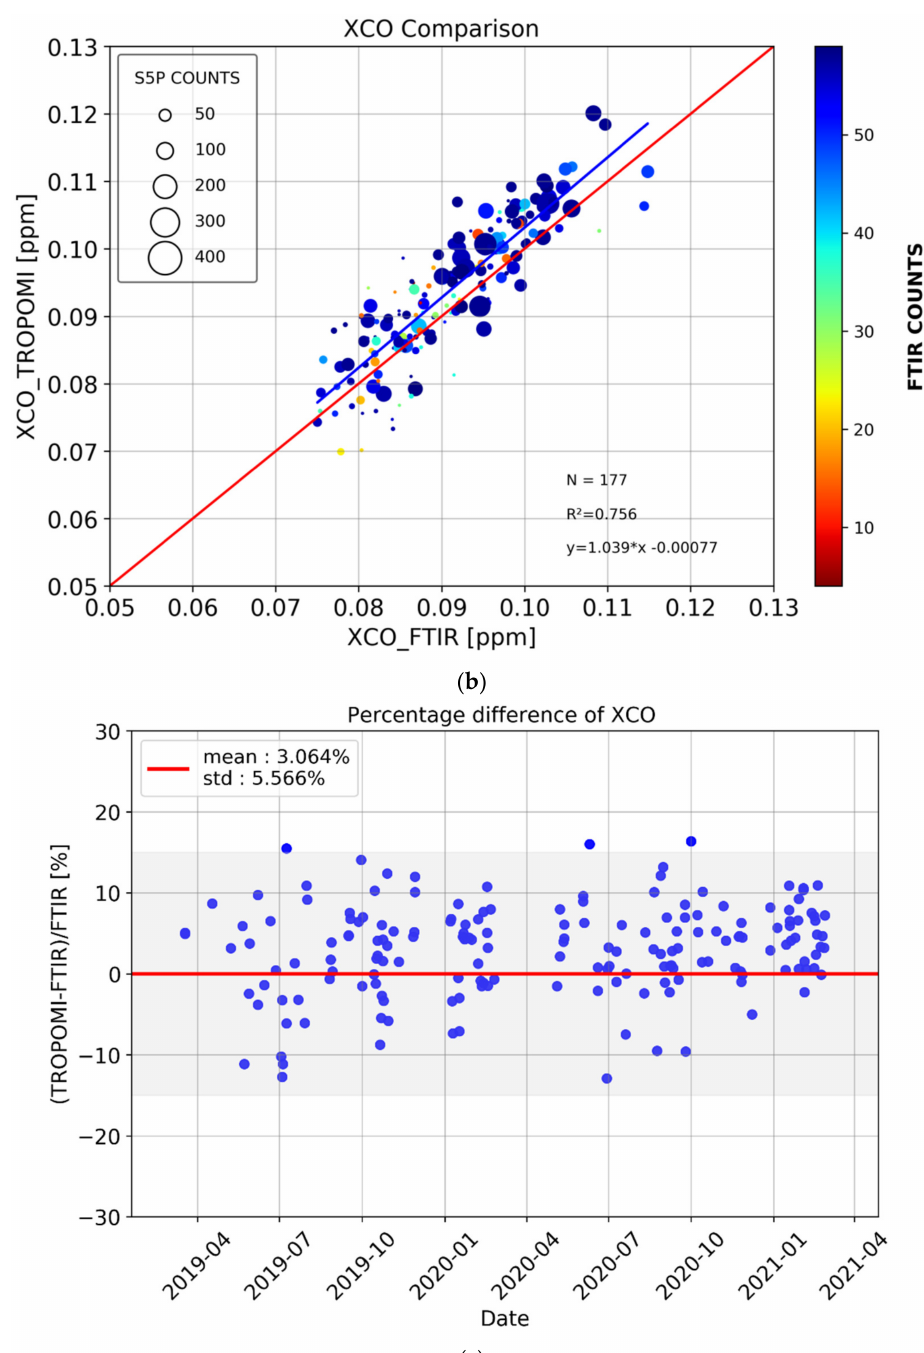
Figure 6. ( a ) XCO daily mean of dry-air column mixing ratios measured by TROPOMI (dark red) and FTIR (blue) under clear-sky and cloudy atmospheric conditions, with associated temporal standard deviation. ( b ) Scatter plot of the two datasets, with the y = x line in red and the linear regression line in blue. Colours and the size of the open circles indicate the number of coincident measurements. ( c ) Percentage difference between satellite observations and FTIR measurements as